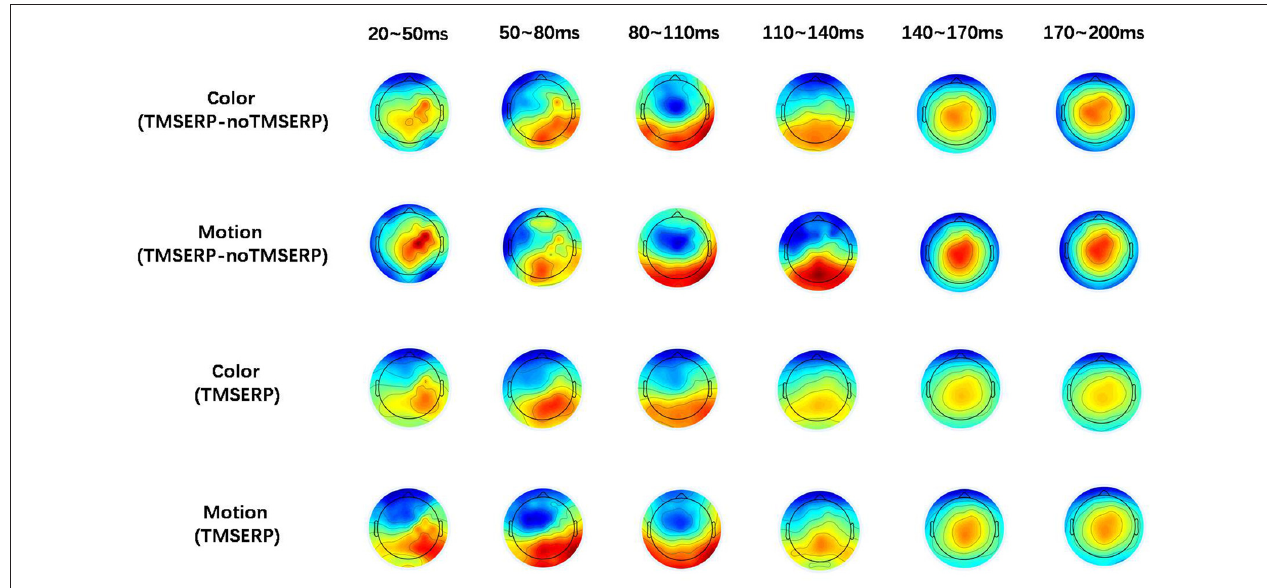
FIGURE 4 | Brain topographic maps. The upper two rows show brain topographic maps of the difference between TMS-ERP and no TMS-ERP during color and motion FBA tasks, respectively. The lower two rows show the brain topographic maps associated with TMS-ERP.